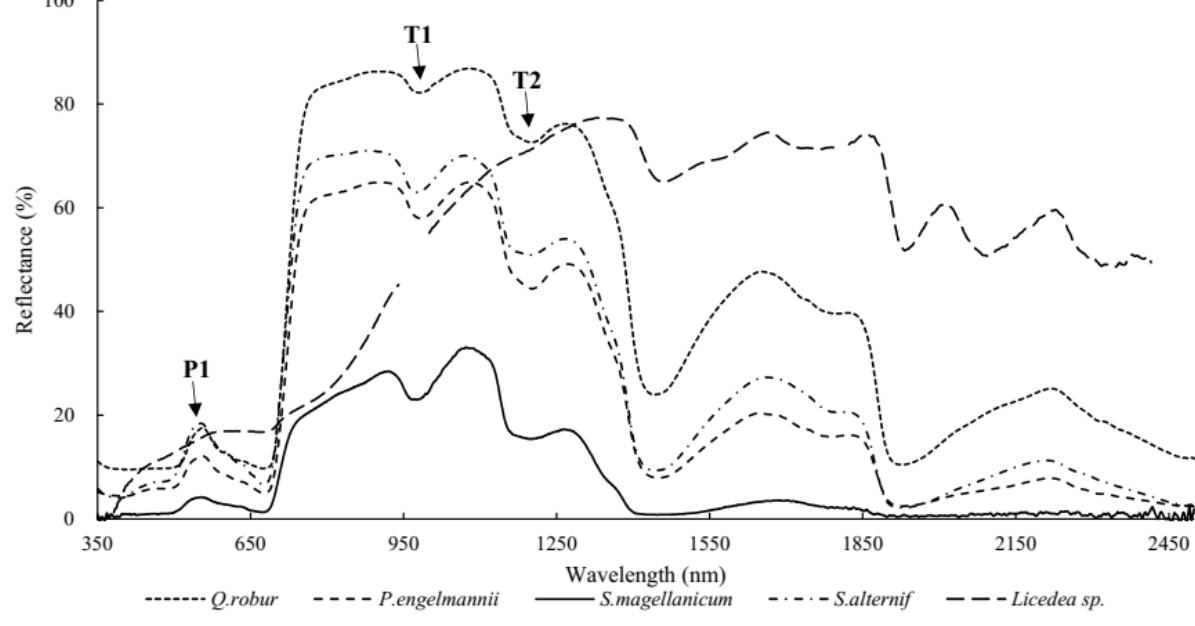
Figure 6. Spectral reflectance of S. magellanicum and other plants. P1 indicates a reflectance peak at ~550 nm; T1 and T2 indicate reflectance troughs at ~950 nm and ~1250